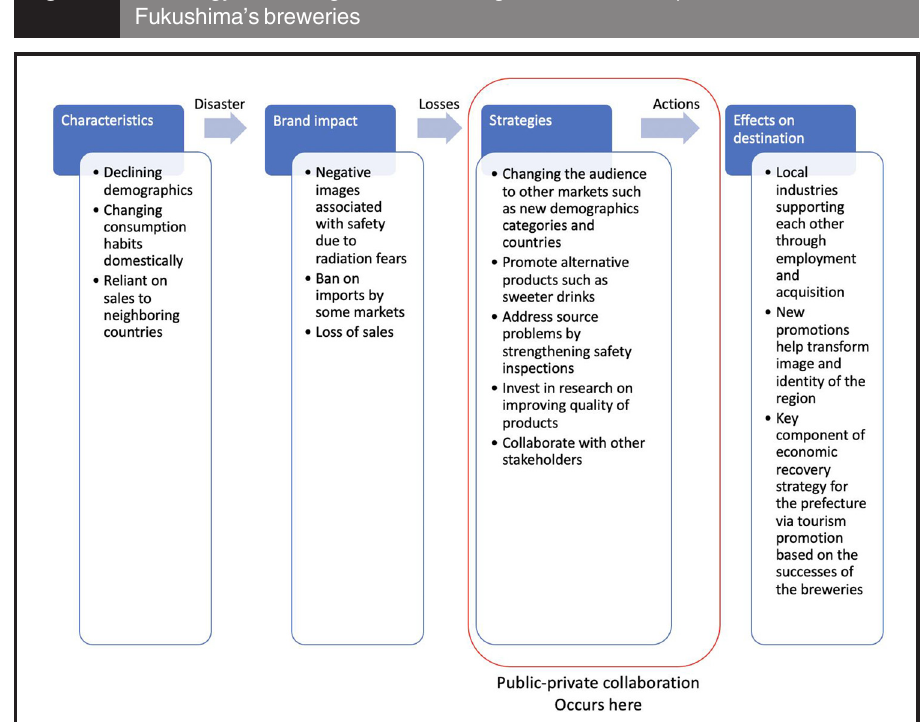
Figure 6 A strategy for altering destination image based on the experiences of Fukushima ’ s